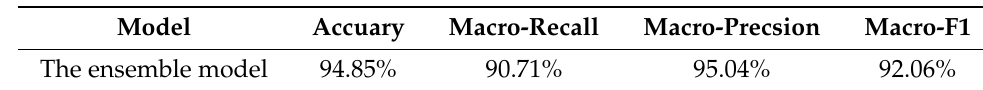
Figure 11. The output of the ensemble model. Table 4. The effect of ensemble